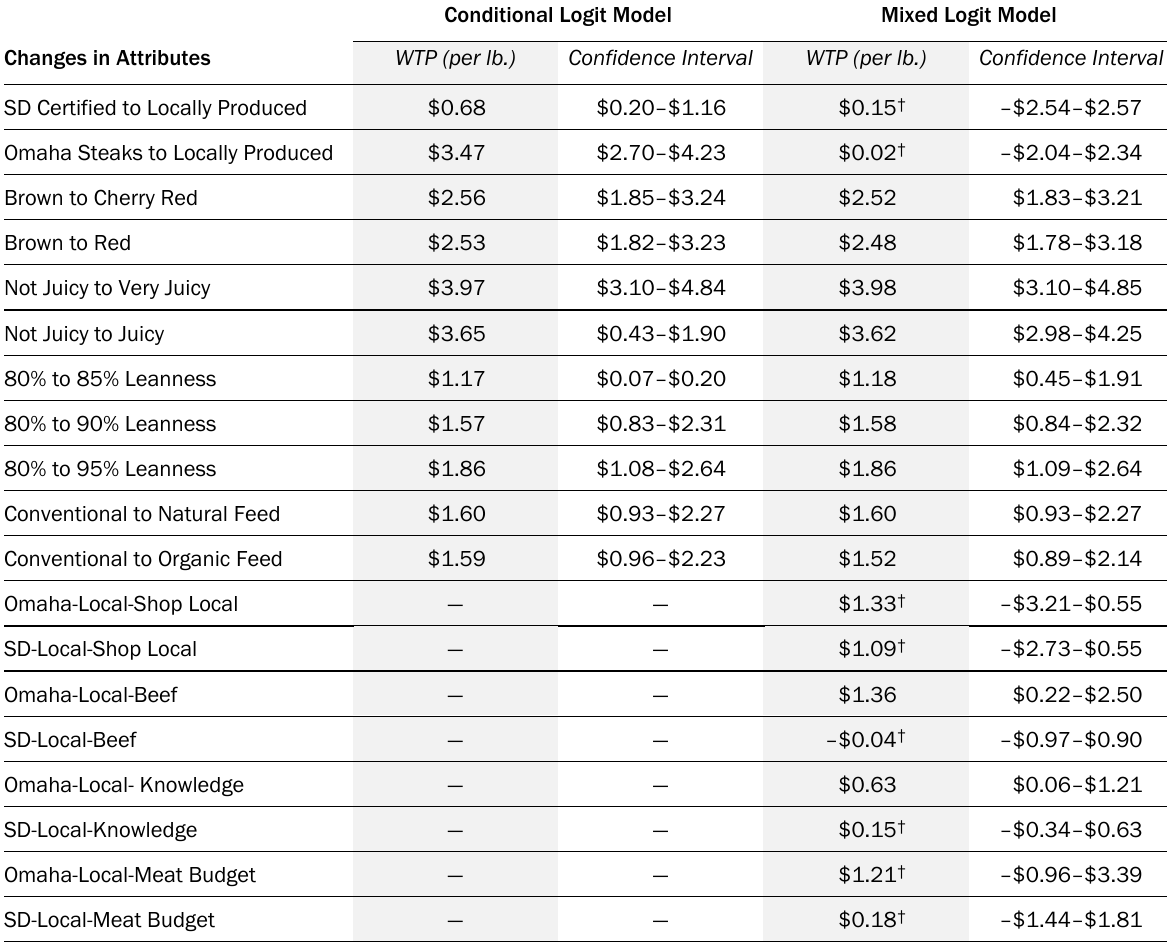
Table 4. Comparing Results of Willingness to Pay and Confidence Interval Using Two Models: Conditional Logit and Mixed Logit Models (all values in US$)